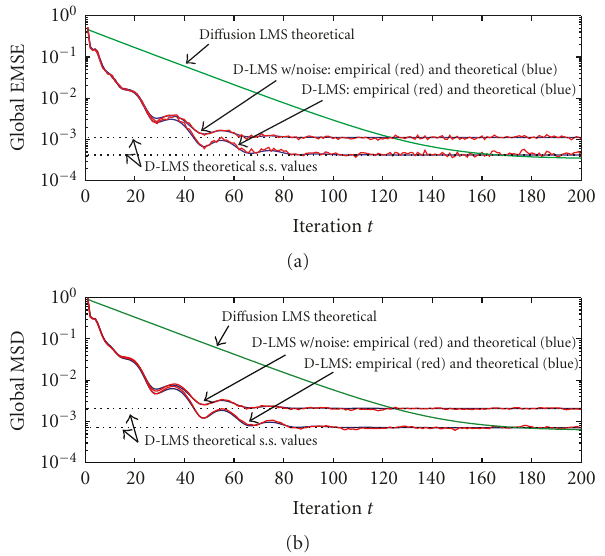
Figure 2: Global performance evaluation for a time-invariant